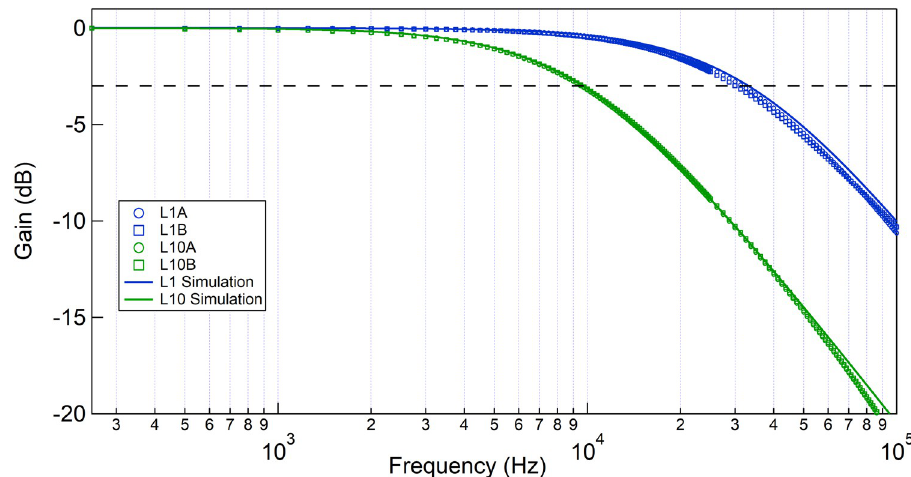
Fig 3. Bandwidth measurement of lab-amplifiers. Frequency response of the constructed amplifiers are shown here. The horizontal black dotted line is the 3dB drop in signal. A 500 k Ω resistor was used for all the measurements. L1 (A&B) and L10 (A&B) amplifiers show bandwidths of 30.9 ± 0.8 kHz, and 9.55 ± 0.05 kHz respectively. Online version in colour.